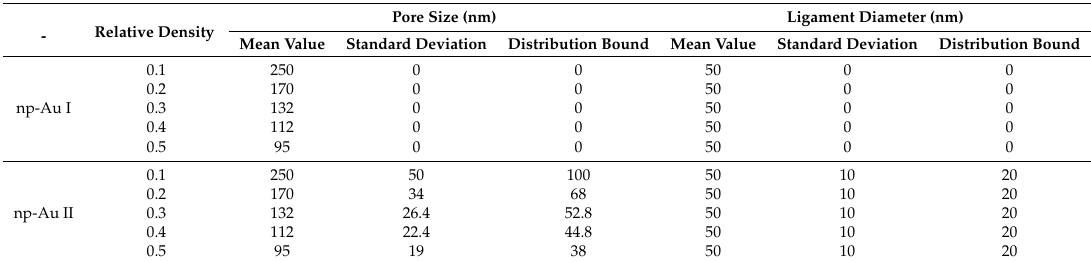
Table 1. Geometrical Parameters of np-Au I and np-Au II.